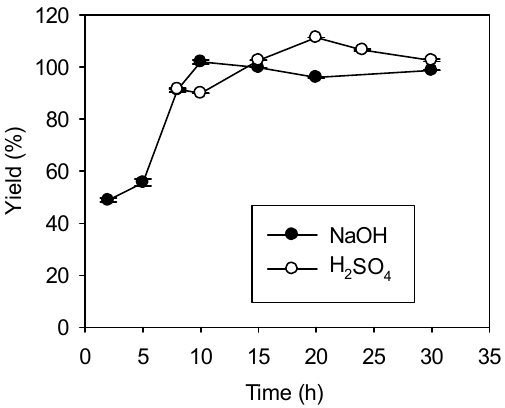
Figure 2. The effect of reaction time on FAME yield. Direct transesterification on 1 g of dry R. glutinis biomass was carried out with a methanol loading of 1:20 (biomass: methanol, w / v ) at 70°C using 1 g/L NaOH or 0.6 M H 2 SO 4 as a catalyst. Data were obtained by averaging three individual measurements and the standard deviations were indicated with error bars.